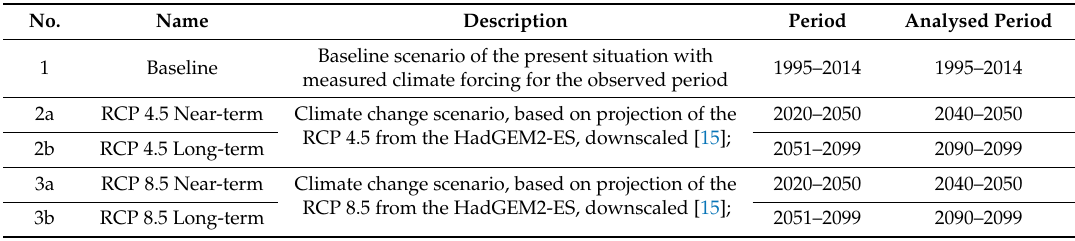
Figure 4. Monitoring network of Minija basin used for model calibration and validation: gauging or debit stations (used for measuring only flowrates) and water quality stations (used for measuring N, P, and other constituents). Table 1. Scenarios for the Minija River